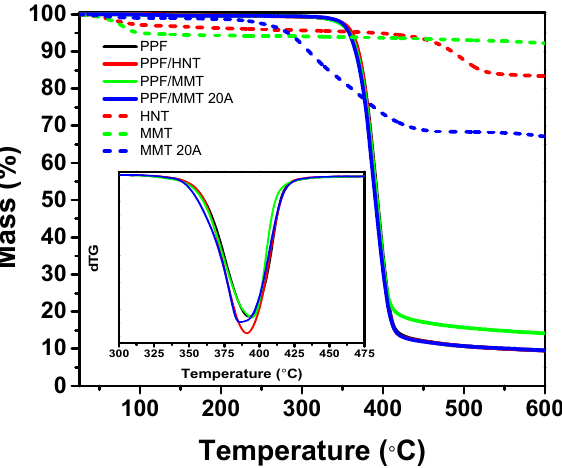
Figure 9. TG and dTG curves (shown inset) of PPF and its nanoclay-based nanocomposites recorded at a 10 °C/min heating rate in nitrogen atmosphere.